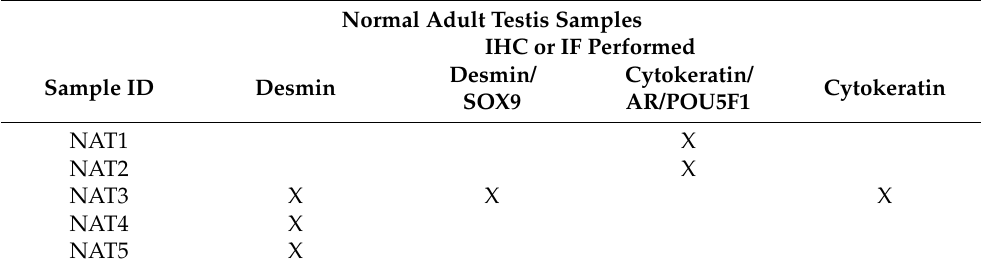
Table A2. Immunohistochemistry and Immunofluorescence performed on normal adult testis samples.